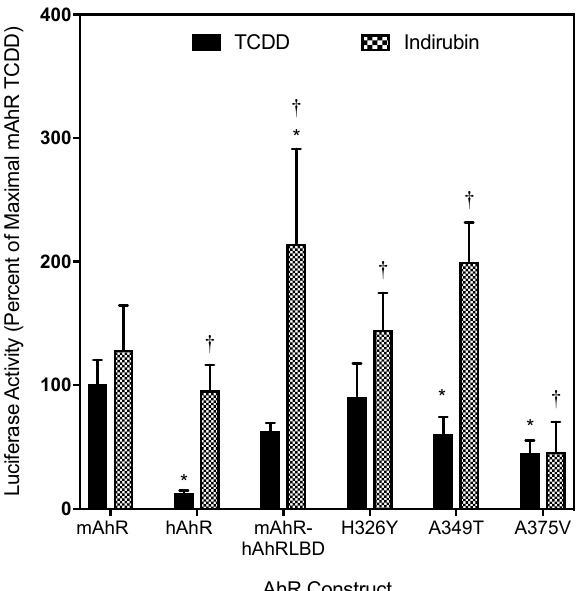
Figure 6. mAhR point mutations alter AhR-dependent reporter gene transcription following TCDD and IR treatment. COS-1 cells transiently transfected with wild-type or mutant mAhR and DRE-containing reporter pGudLuc6.1 were treated with solvent control DMSO (0.1%, v / v ), TCDD (10 nM), or IR (1 µ M) for 18–20 h. Cells were lysed, and lysates were analyzed for firefly luciferase activity. Asterisks indicate the values that are significantly different from the mAhR TCDD or IR, as indicated by Two-Way ANOVA with p < 0.05 and (†) indicate IR values are significantly different from TCDD within the given construct by Student’s t -test p < 0.05. Luciferase activity (relative light units; RLU) was measured and corrected for background (DMSO) and normalized to mAhR TCDD levels. Values represent the mean ± SD of nine individual replicate analyses.